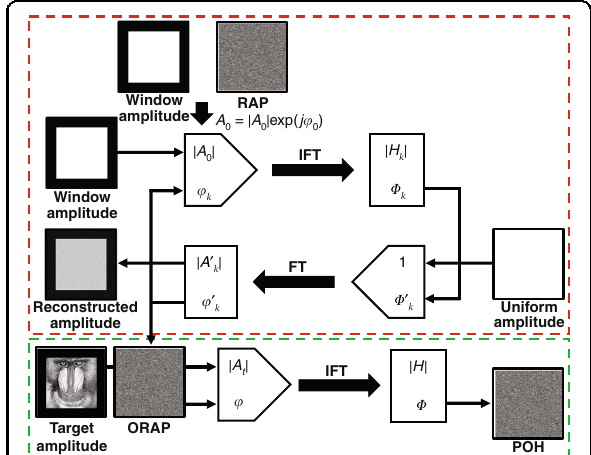
Fig. 5 Flowchart of ORAP